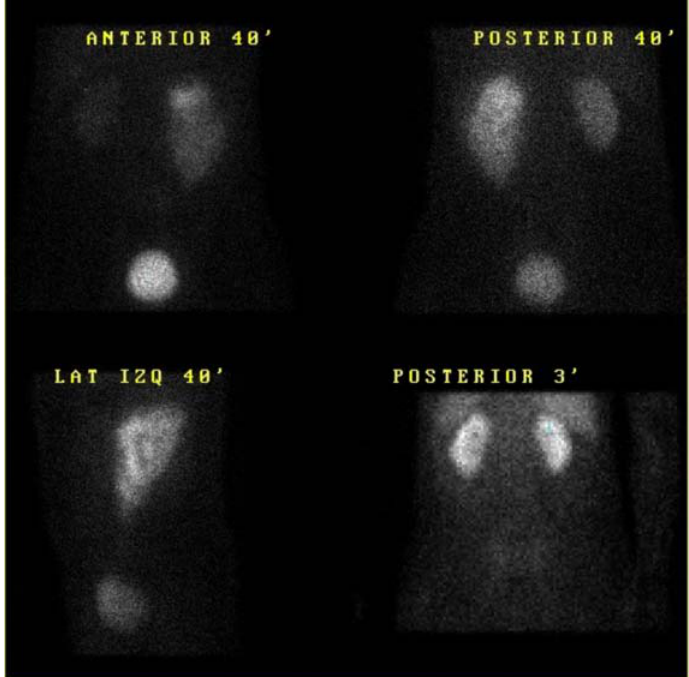
FIGURE 7. Static renal views demonstrate the apparent increase left renal size at 40' in comparison with 3' images, due urine perirrenal